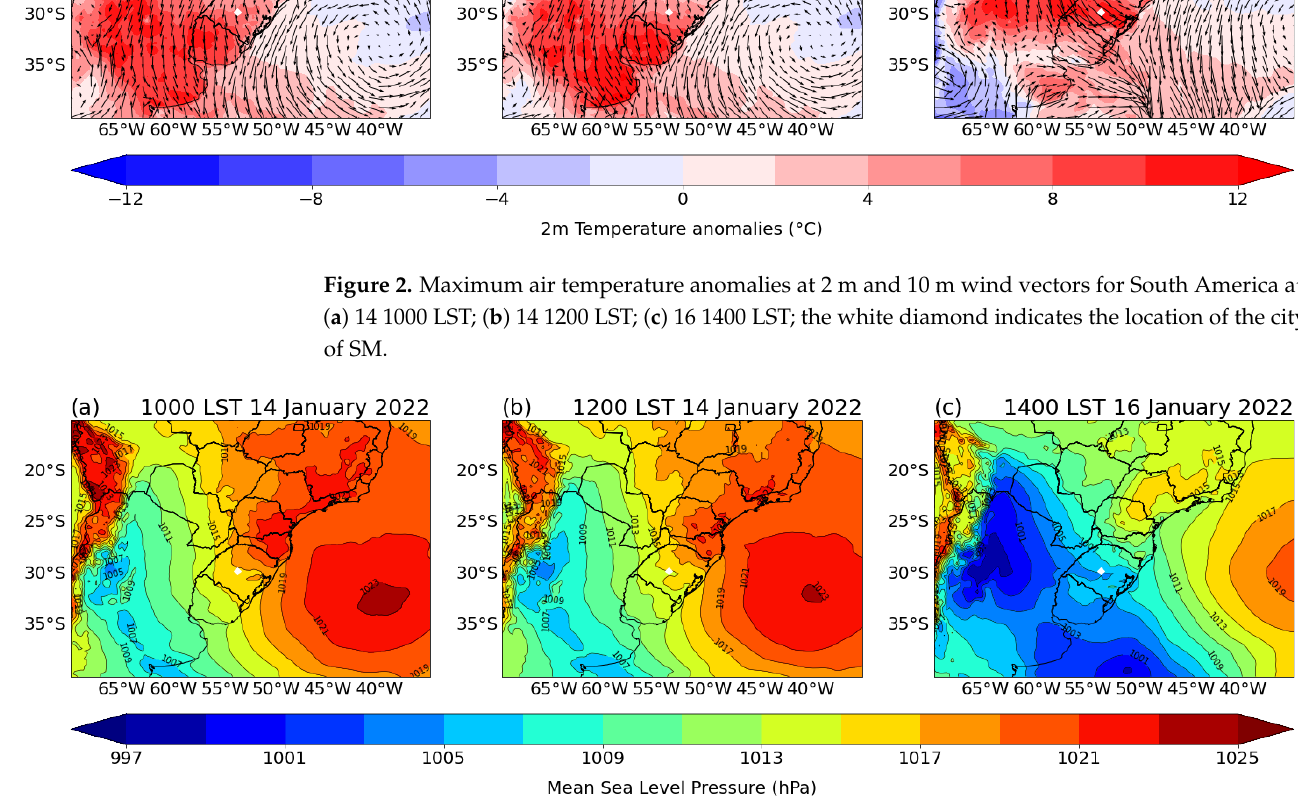
Figure 3. Mean sea-level pressure for South America at: ( a ) 14 1000 LST; ( b ) 14 1200 LST; ( c ) 16 1400 LST; the white diamond indicates the location of the city